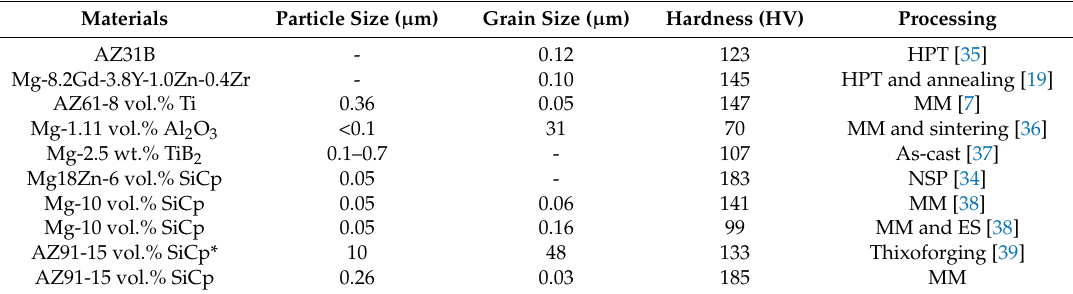
Table 1. Comparison of microstructure and hardness of various Mg alloys.